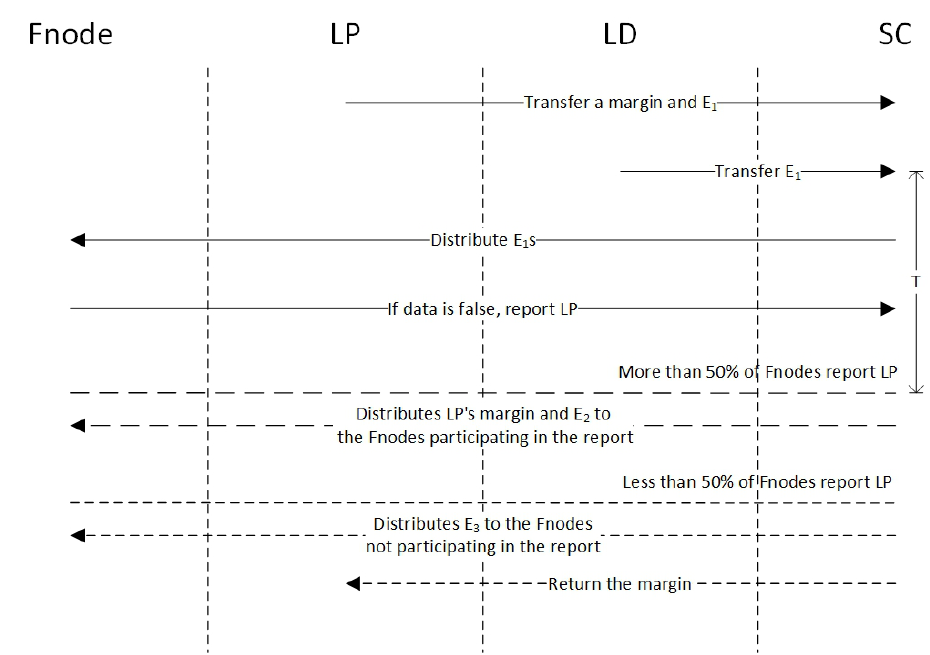
Figure 7. Schematic diagram of the incentive and punishment